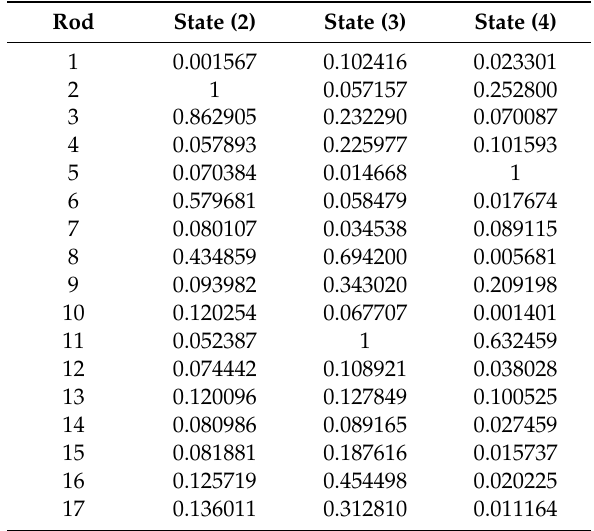
Table A2. The MSECR under each case based on high speed